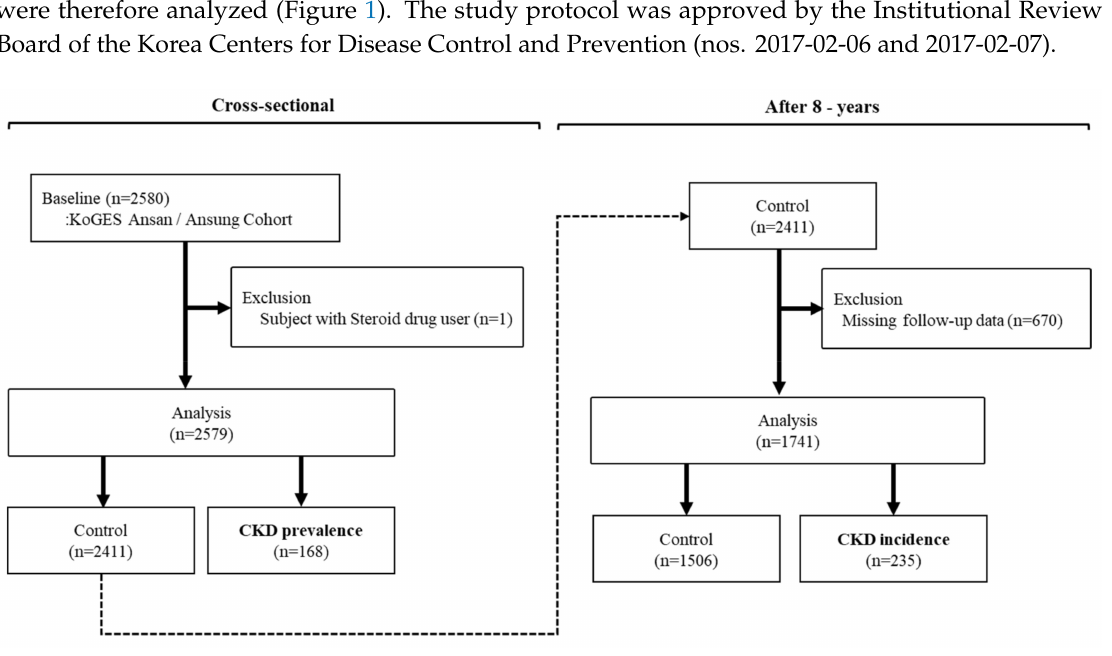
Figure 1. Flow chart of the study